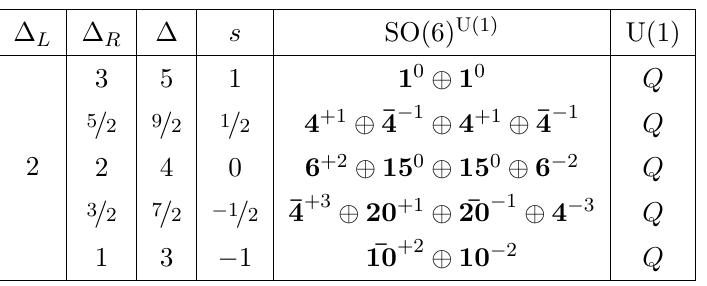
1 ; 1) solution with diagonal embedding (2.21a) with gauge j